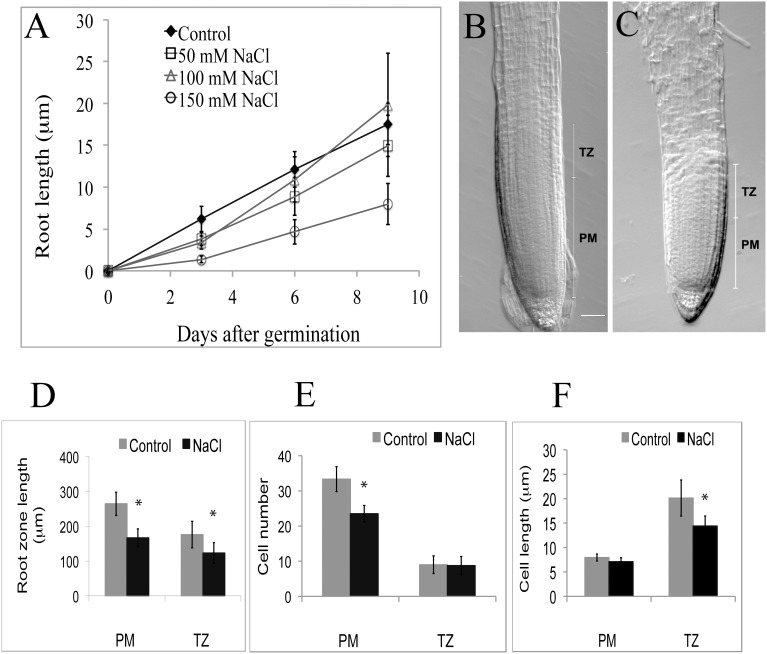
(A–F) Growth parameters of the proximal meristem and transition zone in Arabidopsis primary roots, ± salt treatments. (A) Root length after varying periods of treatment with NaCl (50–150 mM). (B) Intact 3-day-old control root tip. (C) Intact tip from root treated 3 days with 100 mM NaCl. Note the shortening of the PM in the salt-treated root (scale bar = 20 μm). (D–F) Comparison of cellular characteristics of the PM and TZ in roots treated with 100 mM salt for 3 days: D, overall lengths; E, number of cells; F, cell length. PM, proximal meristem, TZ, transition zone, n = 6; *indicates a statistical significance of p < 0.05.